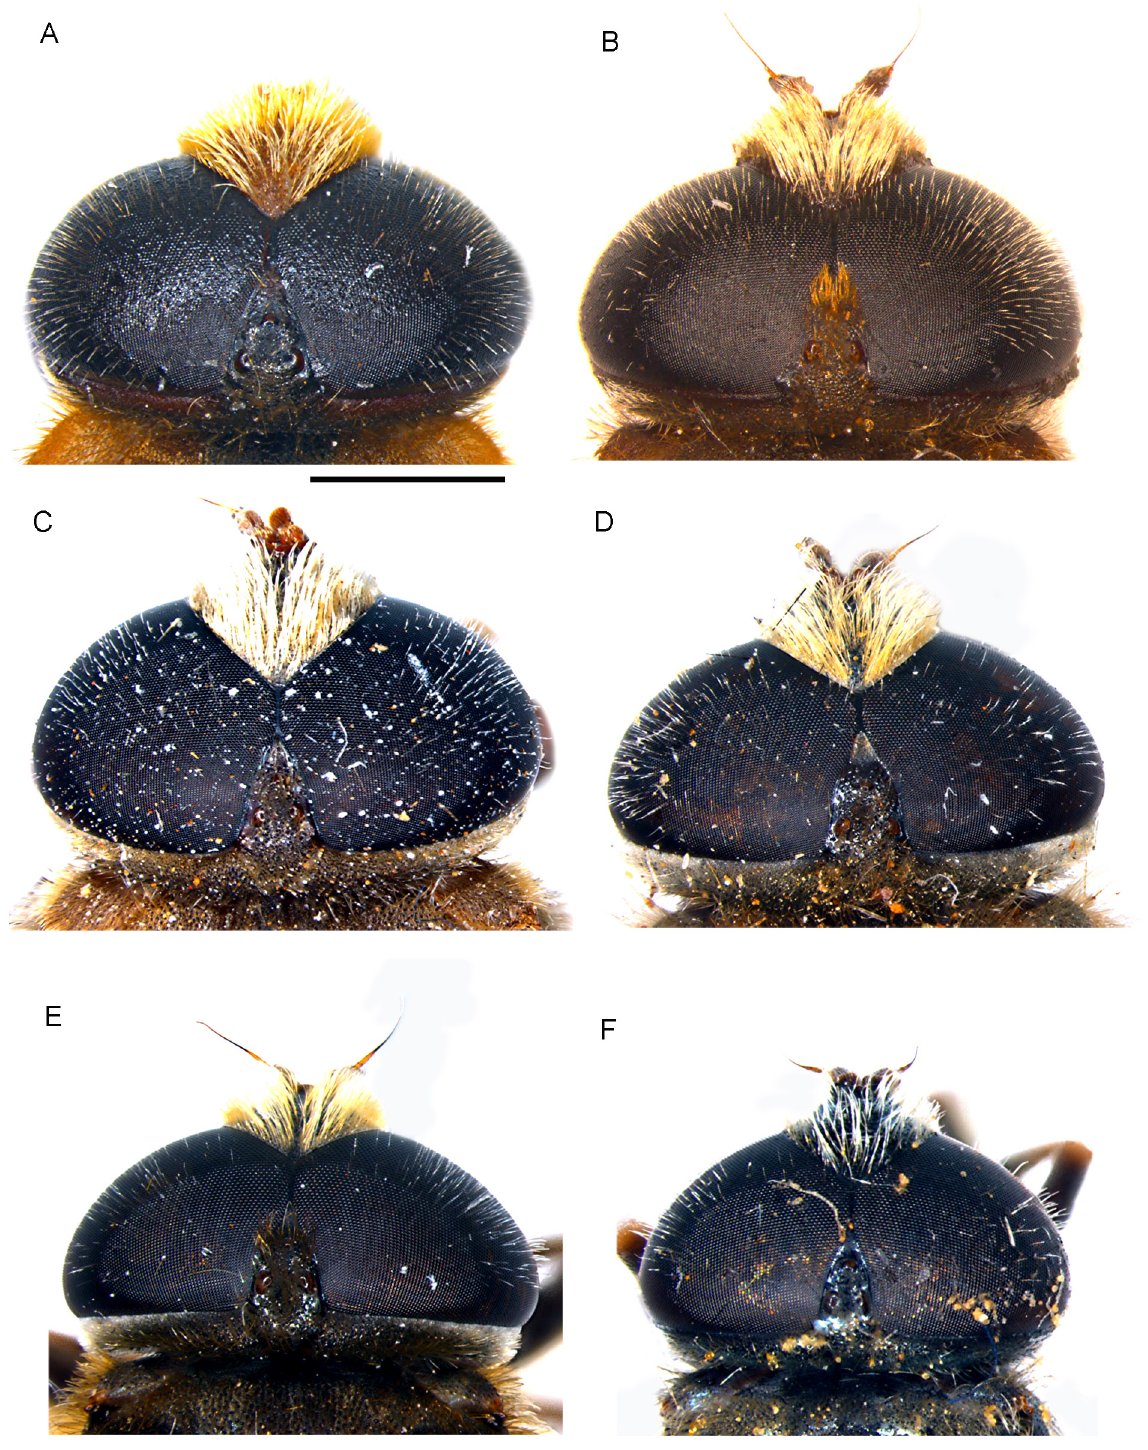
Fig. 12. Male head, dorsal view. A . Merodon bombiformis Hull, 1944 (FSUNS; FSUNS ZA2_079). B . M. multifasciatus Curran, 1939 (USNM 2052372; FSUNS ID 04512). C . M. vittatus Vujić & Likov sp. nov., holotype (NBCN; FSUNS ID 04085). D . M. zebra Vujić & Radenković sp. nov., holotype (RMCA; FSUNS ID 25089). E . M. lotus Vujić & Radenković sp. nov., paratype (FSUNS; FSUNS ID ZA6_066). F . M. nasicus Bezzi, 1915 (TAUI; FSUNS ID 04972). Scale bar = 2